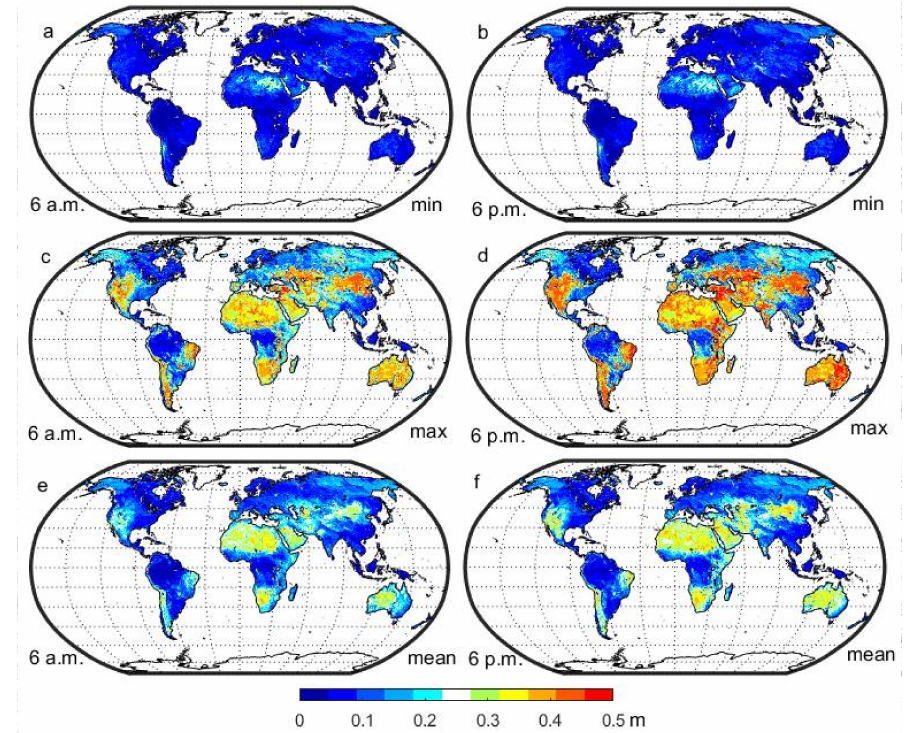
Figure 5. Global map of the penetration depth (PD) for SMAP with ( a ) minimum at 6 a.m.; ( b ) minimum at 6 p.m.; ( c ) maximum at 6 a.m.; ( d ) maximum at 6 p.m.; ( e ) mean at 6 a.m.; ( f ) mean at 6 p.m. Data used are SMAP soil moisture passive L3 product and the corresponding soil effective temperature calculated from MERRA-2 for 2016. The SMAP soil moisture and soil effective temperature are considered as the mid-level values for each pixel